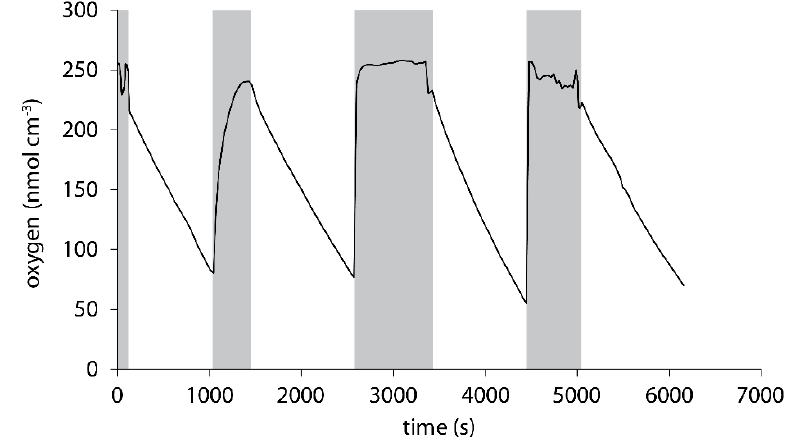
Figure 4. Typical respiration measurement with the percolation method; R O2 = 0.14 ± 0.02 nmol cm −3 s − 1 (HE-447 / 52). The light-grey background indicates core flushing with oxygenated water; the white background indicates the respiration measurement with stagnant pore water.